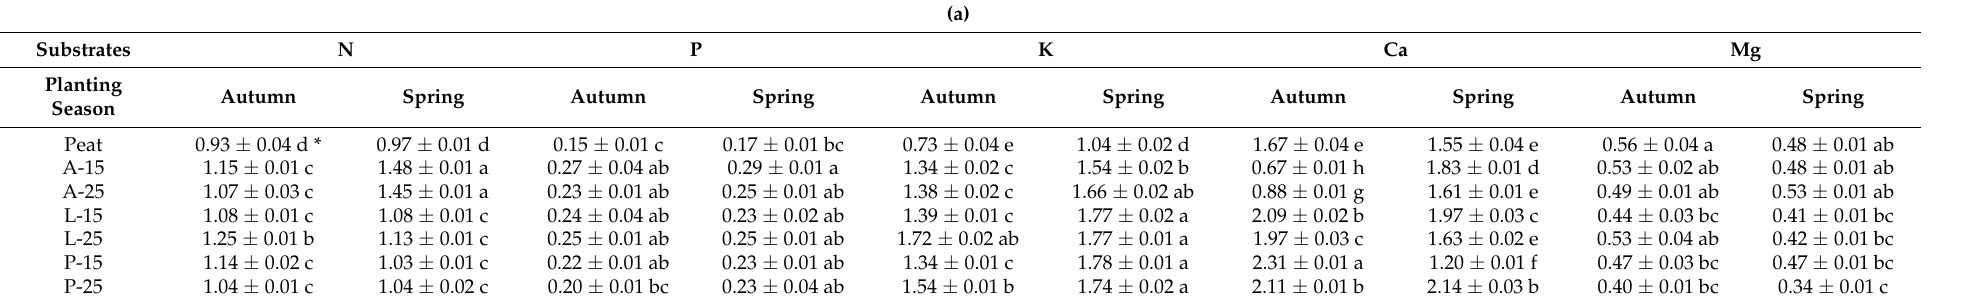
* means in columns within each nutrient followed by the same letters are not significantly different at p < 0.05 according to Tukey’s HSD ( n = 3). Table 13. ( a ) Macronutrient concentrations in the strawberry crowns (%DW). ( b ) Sodium (%DW) and micronutrient (mg · kg − 1 DW) concentrations in strawberry crowns.